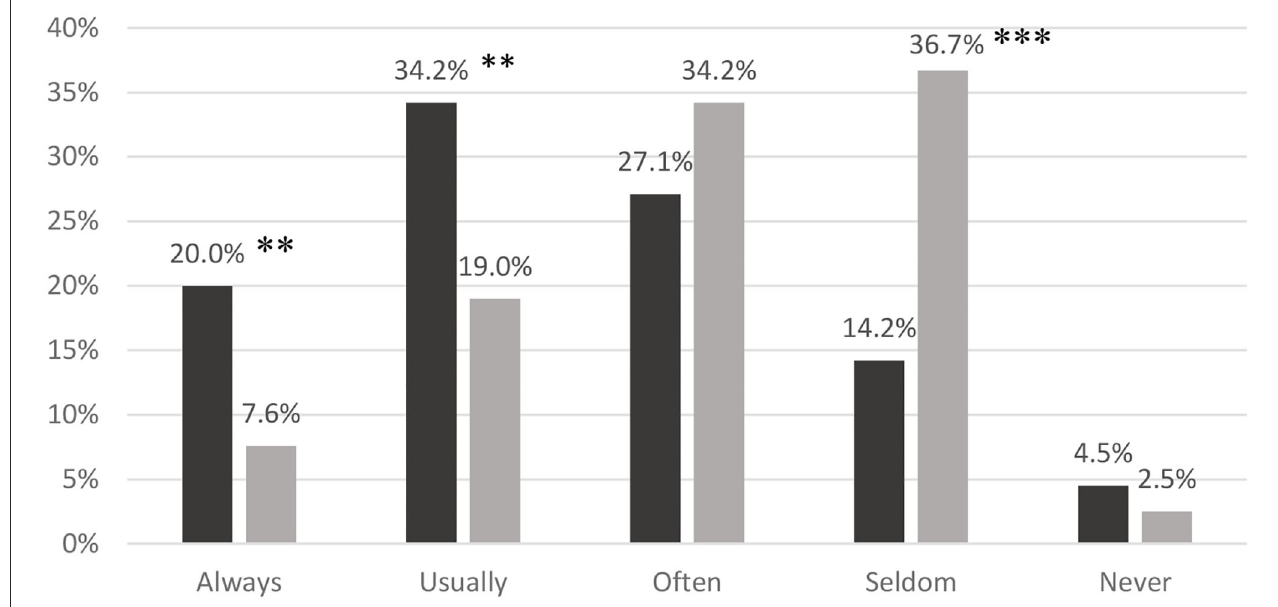
FIGURE1 Organic preferences for regulars (dark) and non-regulars (light). **Significant difference at 5%, ***Significant difference at 1%.